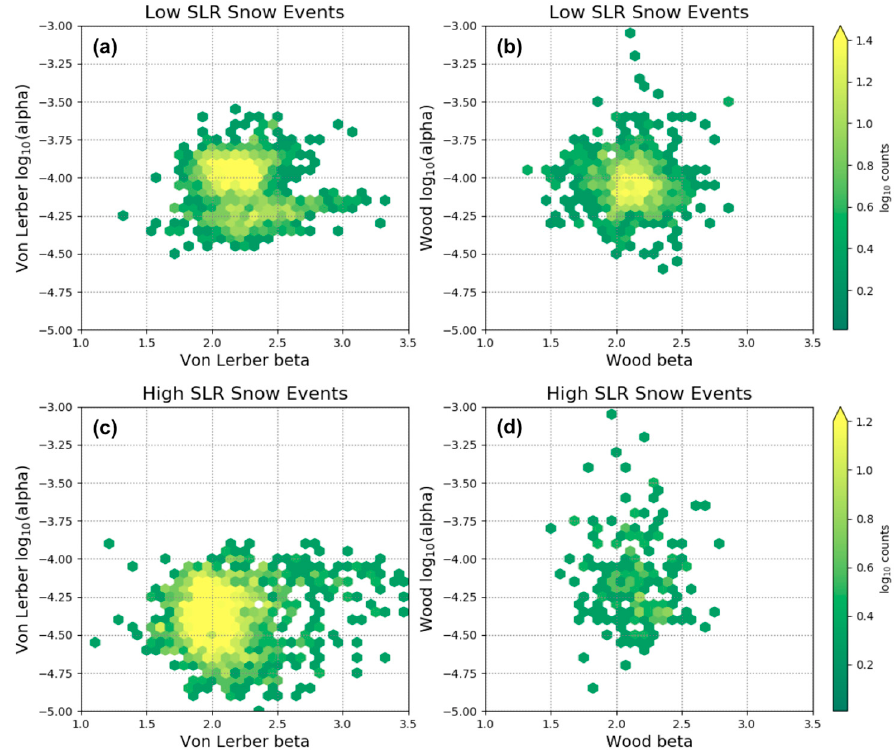
Figure 5. The α and β output as calculated for the low SLR snow events are shown in ( a ) (von Lerber) and ( b ) (Wood). The α and β output as calculated for the high SLR snow events are shown in ( c ) (von Lerber) and ( d ) (Wood). Note that α values are shown as log 10 scaled. There are fewer points in the Wood-retrieved output due to the filtering of times when the Pluvio does not report any accumulation.